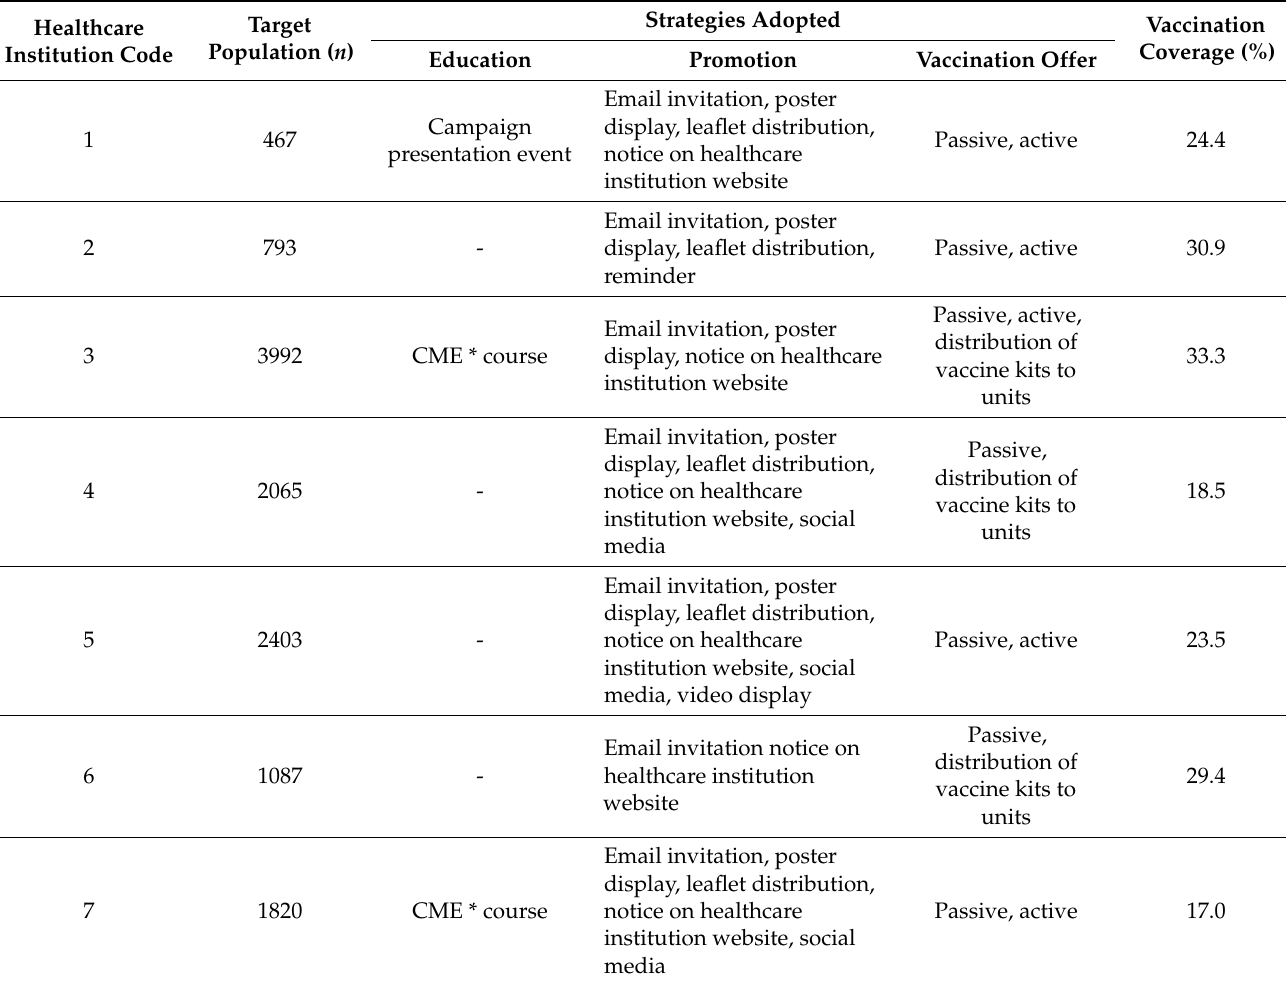
Table 2. Strategies adopted for the 2019–2020 influenza vaccination campaign and outcomes.